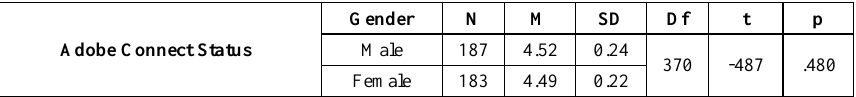
Table 7. Adobe Connect Situations by